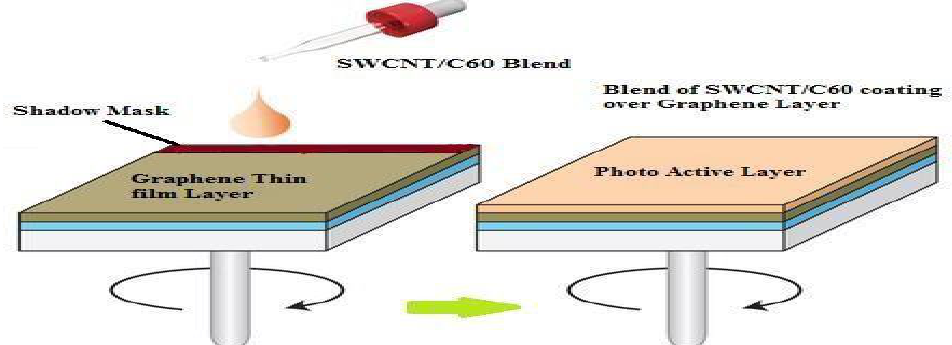
Figure 3. Spin coating of Active layer over graphene thin film Layer.